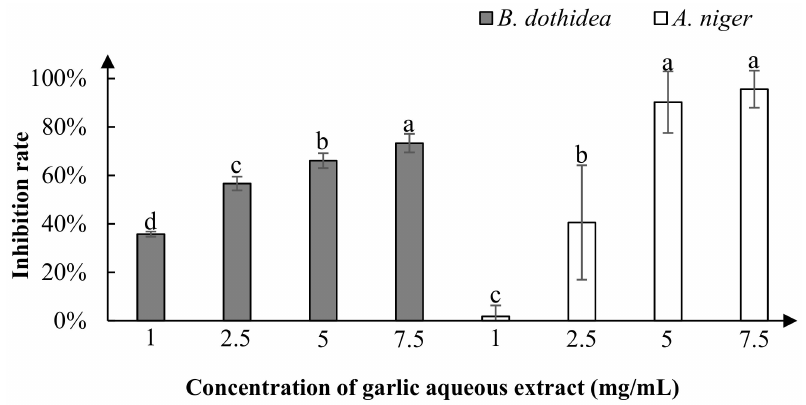
Figure 10. The inhibition rate of the aqueous garlic extract on A. niger and B. dothidea. (The values are the means and the error bars indicate the standard deviations. Di ff erent letters (a / b) indicate significant di ff erence between di ff erent concentrations of aqueous garlic extract within each pathogen, n = 3).